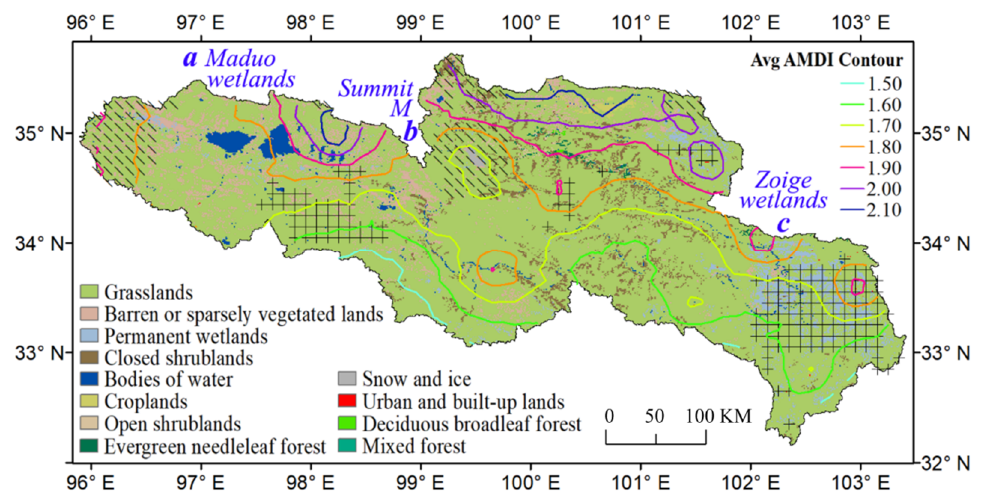
Figure 13. Land cover map combined with the information in Figure 7, the isolines of the mean value of AMDI during 1979–2015 and the areas with AMDI significant trends over the SRYR, and three regions with typical underlying surface, marked with a , b and c .